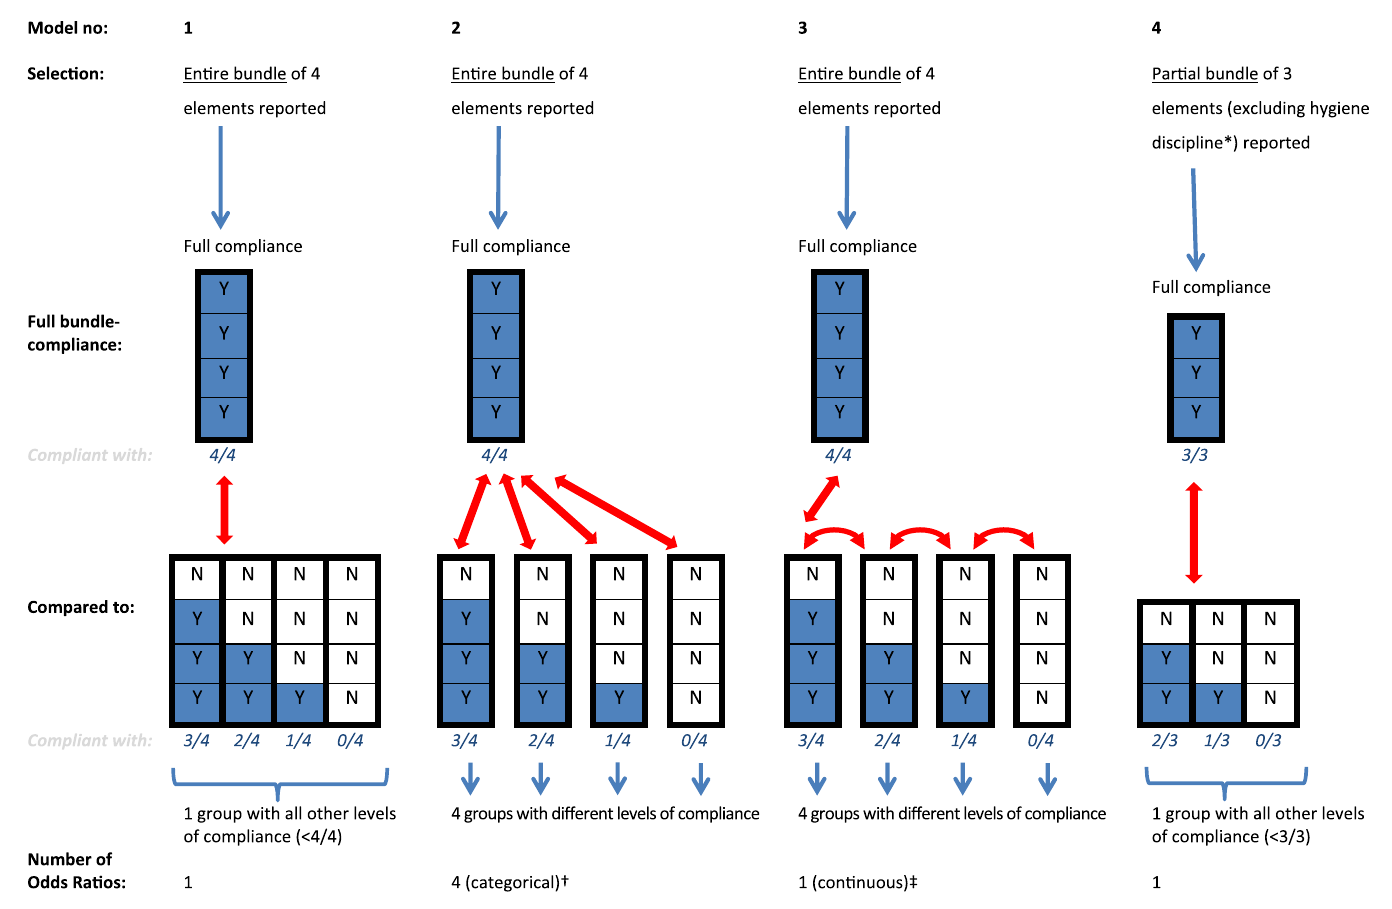
Fig 1. Statistical analysis: Four analysescomparing the influence of bundle-compliance on the SSI-risk. Comparisons made in Models 1 to 4 schematically represented.A stack of four boxes represents the entire bundle,a stack of three boxes represents the partial bundle.Compliancewith a single bundleelement is presentedas a blue box with a Y (= Yes). Non-compliancewith a bundleelementis presentedin a white box with an N (= No). Only bundles being completelyreportedwere included(N = 62 486 for entire bundle, N = 99 371 for the partial bundle).Bundleswith missing data concerning compliance were excluded.Key: * Model 4: The partial bundledoes not includethe bundleelementhygienediscipline(‘minimising operatingroom door movements’), but is only composed of the bundleelementsPAP-LG, hair removal and normothermia. † Model 2: Level of complianceentered as a categorical variableproduces 4 Odds Ratios (ORs), comparing full compliancewith the four other levels of complianceseparately. ‡ Model 3: Level of compliance entered as a continuous variable produces 1 Odds ratio (OR), signifyingthe reducedrisk for each single point increasein compliance-level.